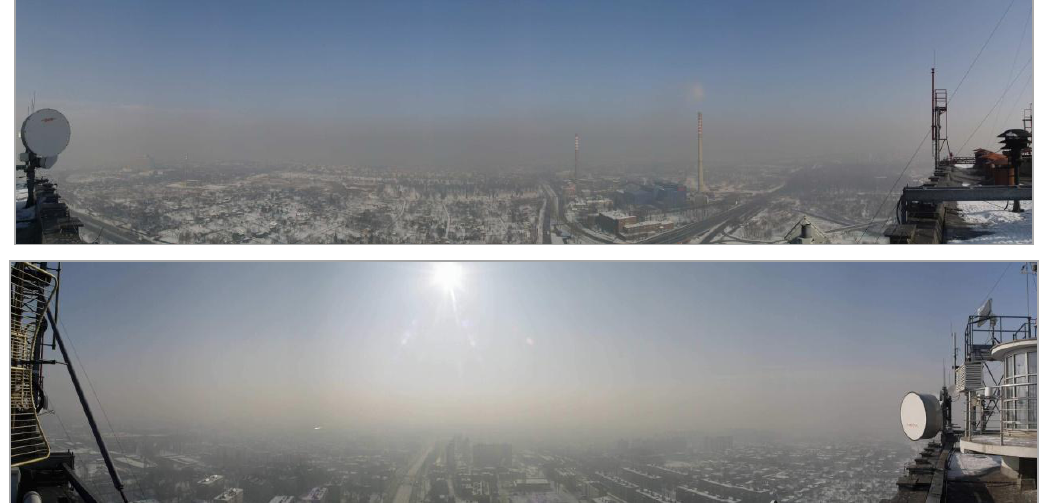
Fig. 5. The concentration of air pollutions during thermal inversion episode in Sosnowiec. Date: 8 February 2005. Time: 10:57 UTC. Location: roof of the Faculty of Earth Sciences. Direction: N (up) and S (down) ( A. Widawski